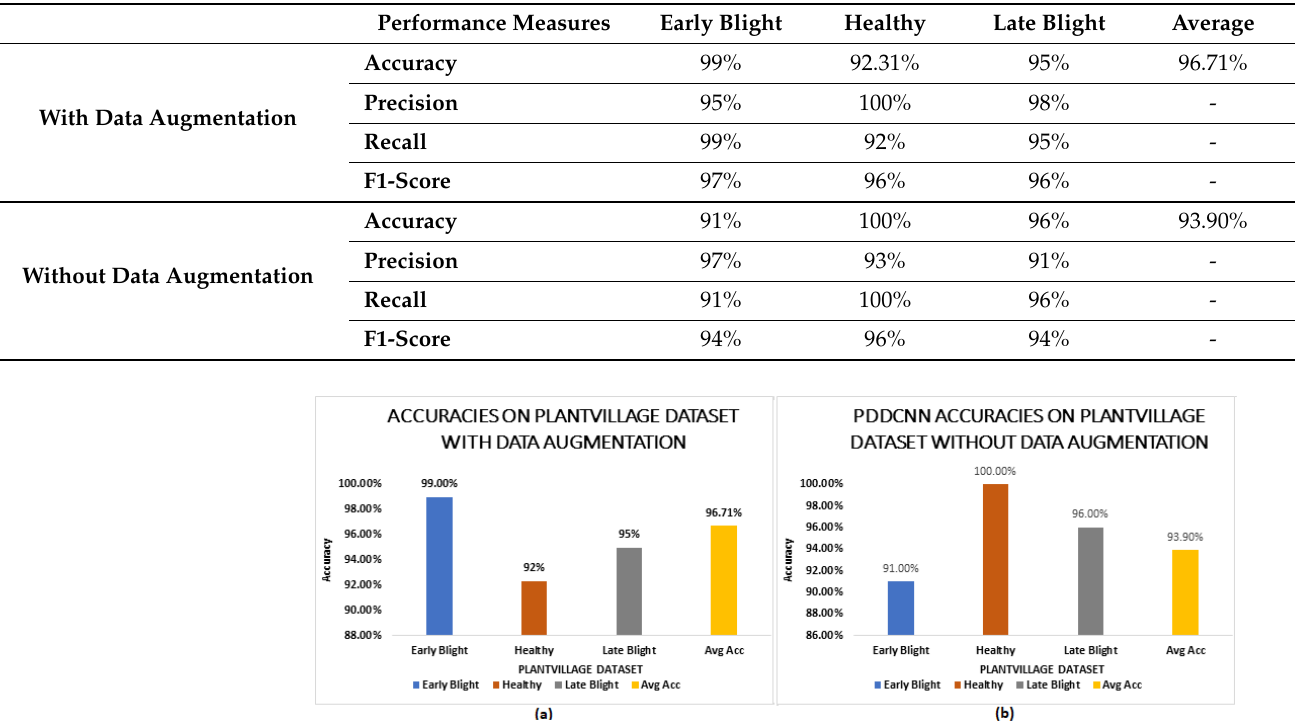
Table 8. Classification accuracies, precision, recall & F1-score of the proposed PDDCNN model on the PlantVillage dataset.